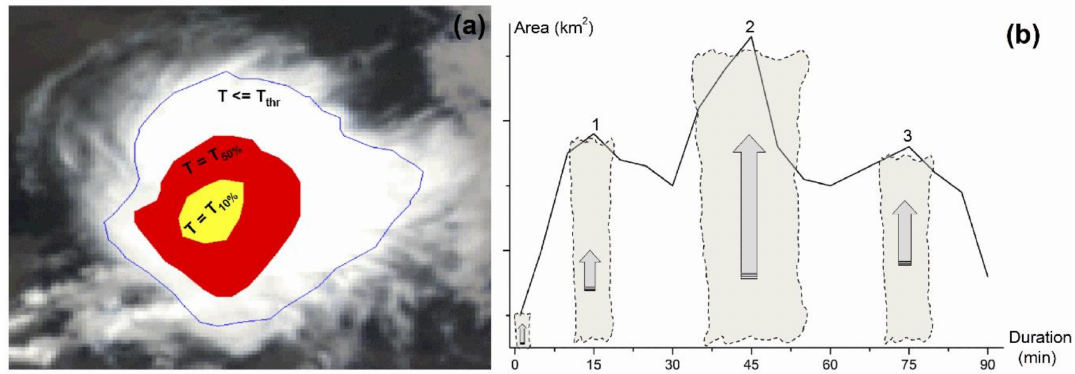
Figure 1. ( a ) A convective cloud cell as delimited through Meteosat imagery (Kolios, 2009). The red and yellow colored internal areas depict very cold isotherms where active convection can occur; ( b ) Schematic representation of the fluctuations regarding the cloud top areal extent during a typical MCS lifecycle. of the areal extent. Any of the local maxima that fulfill the criterion of the equation 1 was considered capable of producing